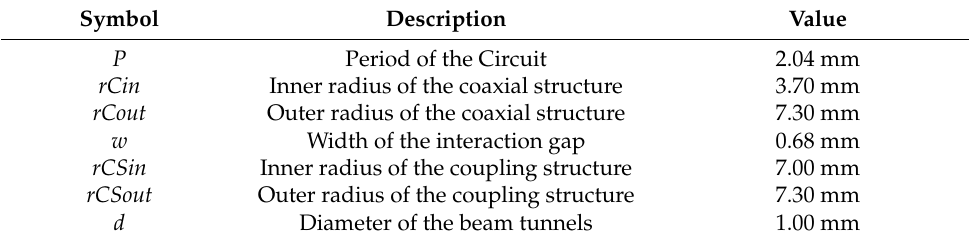
Figure 1. The cross-sectional views of layout of the circuit of multiple-beam extended interaction oscillator (MBEIO). ( a ) The cross-sectional side view. ( b ) The cross-sectional front view. Table 1. Specific Parameter for the MBEIO